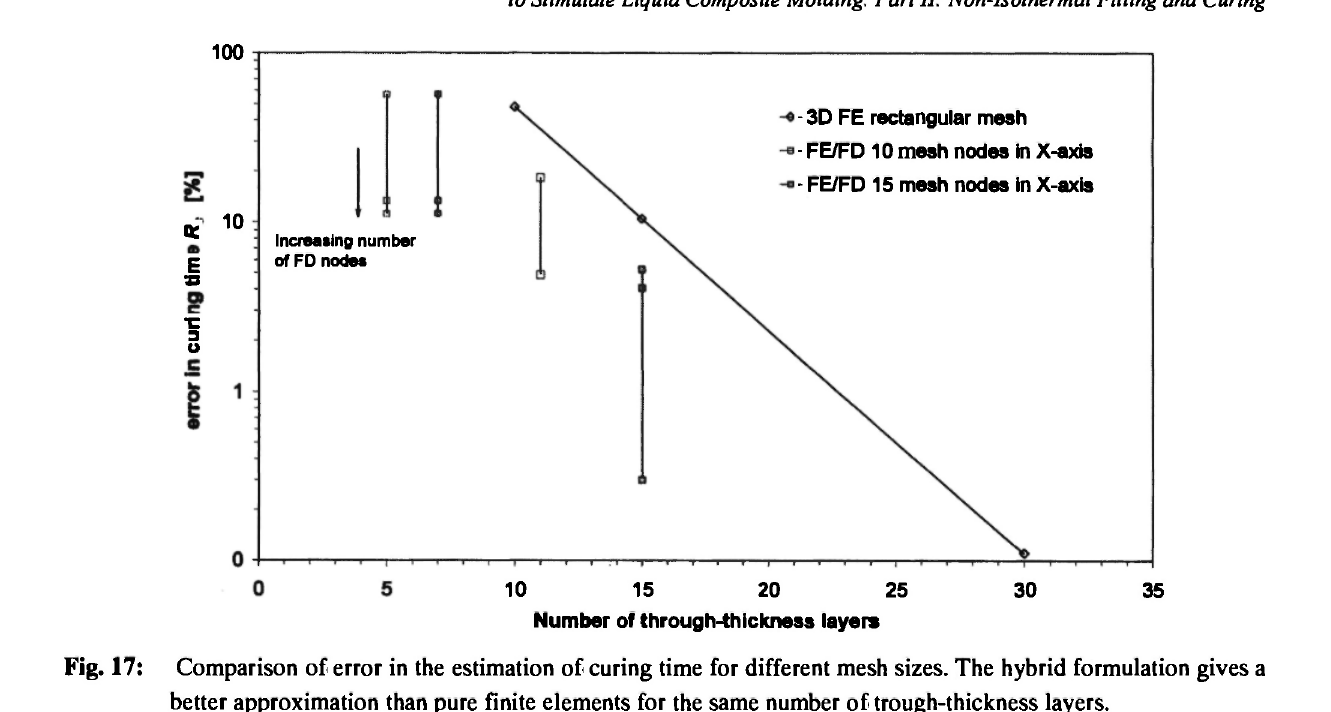
Comparison of error in the estimation of curing time for different mesh sizes. The hybrid formulation gives a better approximation than pure finite elements for the same number of trough-thickness layers.